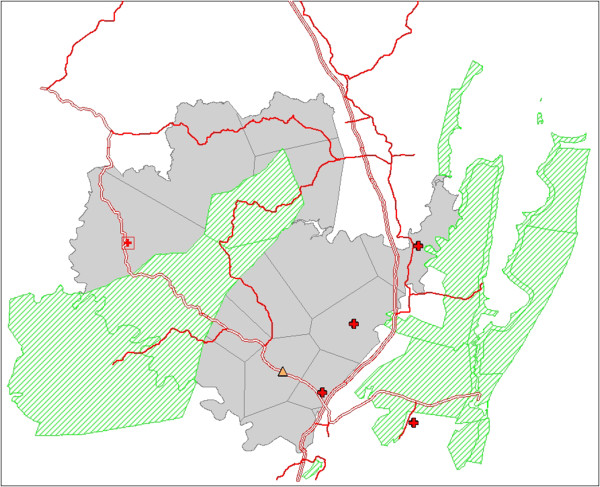
Map of Hlabisa sub-district. Figure 1 shows a map of Hlabisa sub-district (in grey) and the location of the clinics in which the study was conducted. The primary healthcare (PHC) clinics are shown as red crosses; the square with a red cross indicates the location of the PHC clinic located on the premises of the district hospital. The Africa Centre is shown as a yellow triangle.